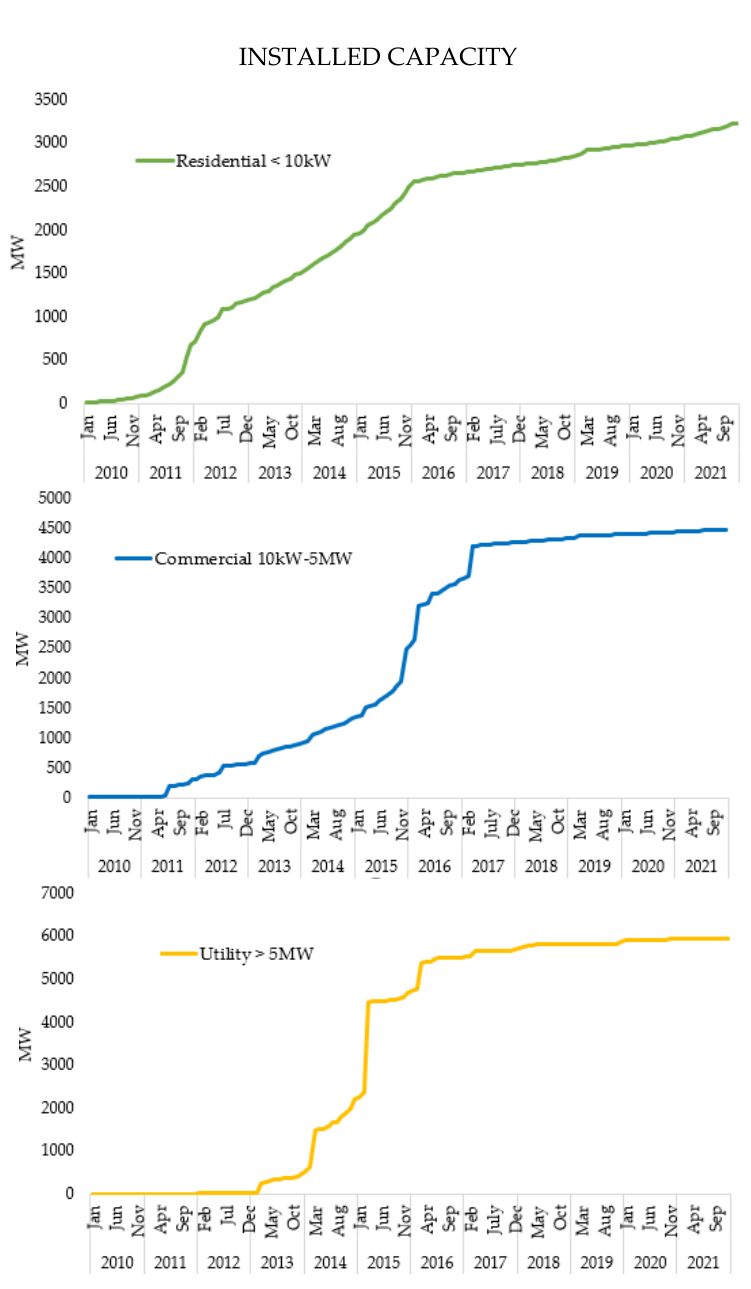
Figure 1. Monthly cumulative installed capacity of solar PV (in MW) by sector: residential (green), commercial (blue), and utility (orange) from January 2010 to November 2021. Data from [27].